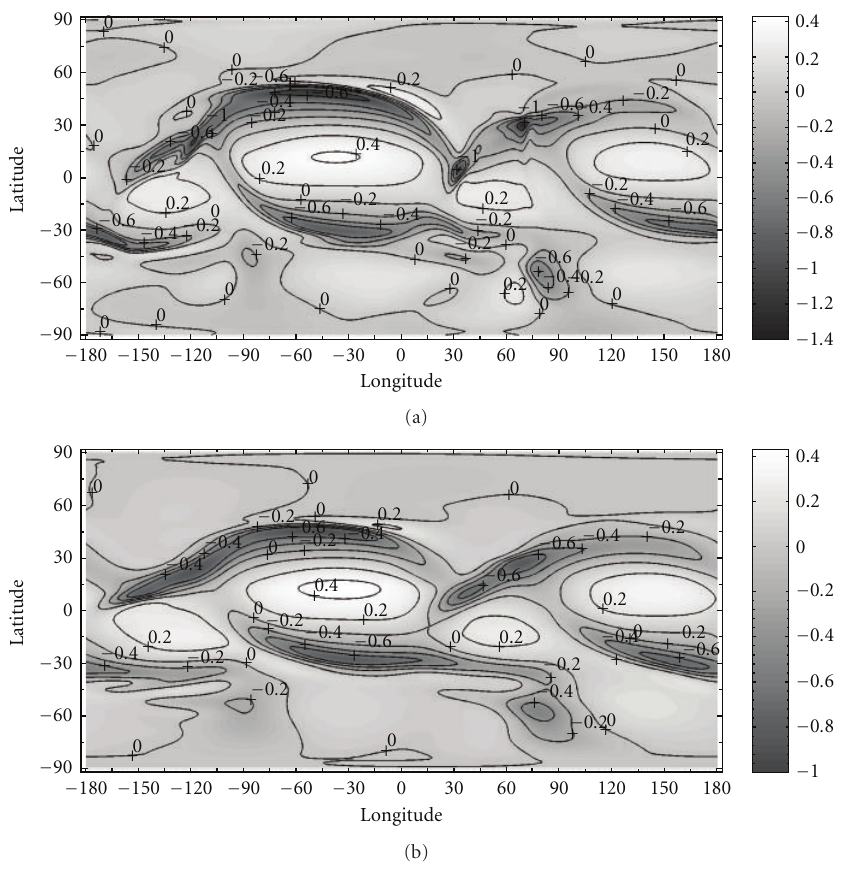
Figure 7: The same as in Figure 6 but at the altitude of